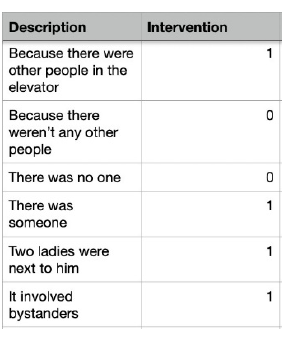
Figure 18. Short textual description model.